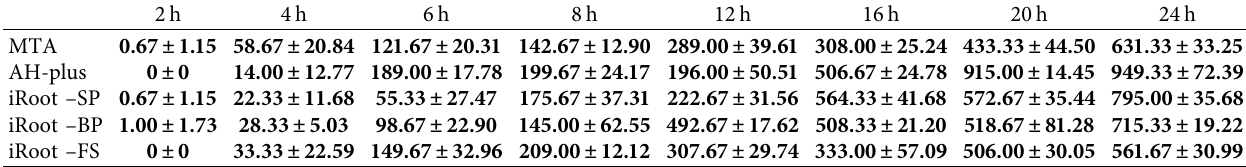
Table 10: Enterococcus faecalis group (electron microscopy